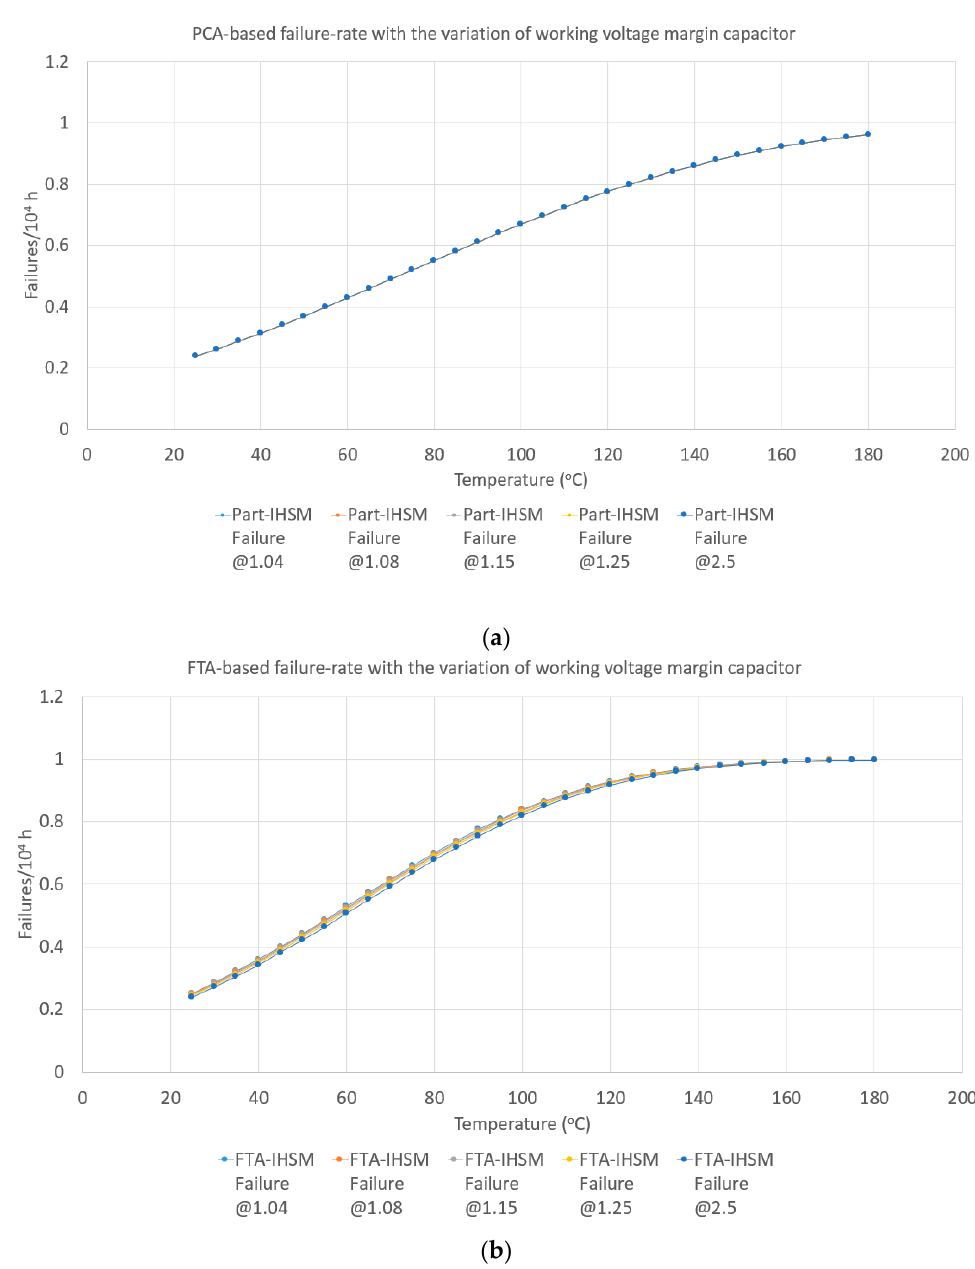
Figure 24. Failure rate with the variation of working voltage margin of capacitor, ( a ) PCA-based, ( b ) FTA-based.